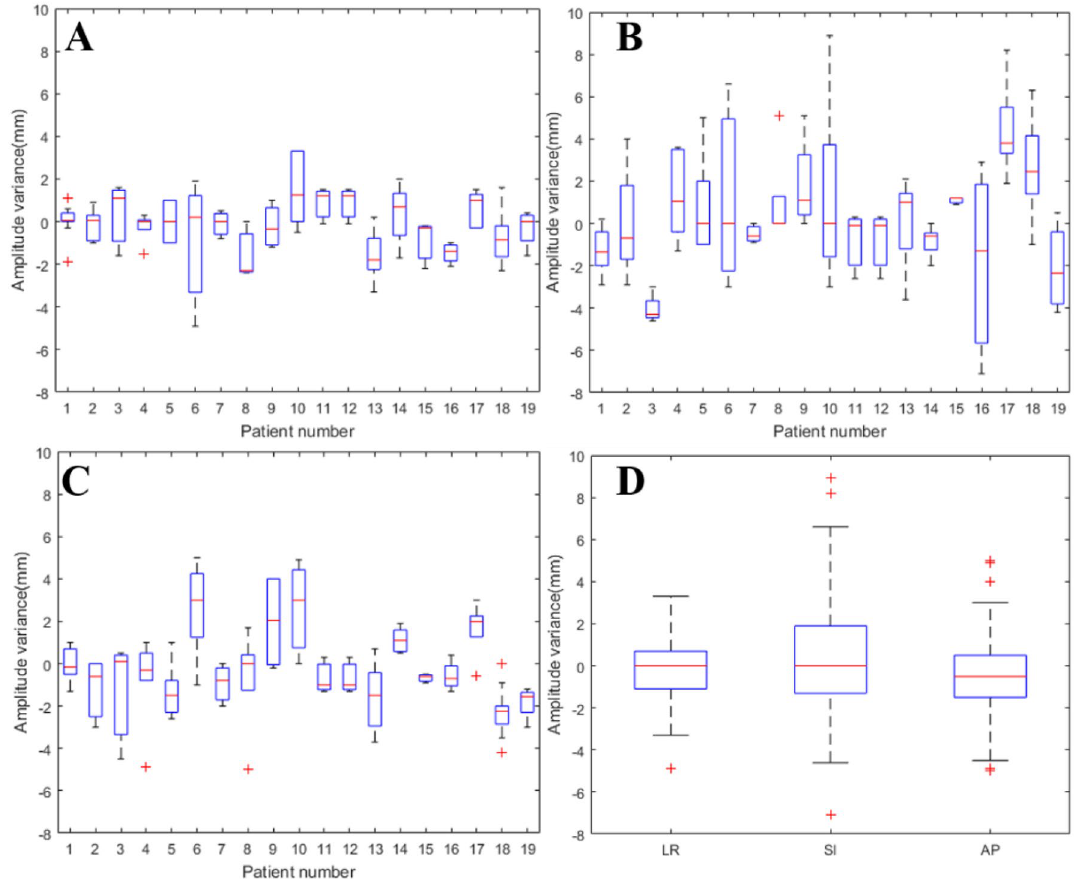
Figure 4. Inter-fractional tumor amplitude variance in LR, AP, and SI directions for 19 patients ( A : values in LR direction, B : values in SI direction, C : values in AP direction, D : statistic values in three directions).